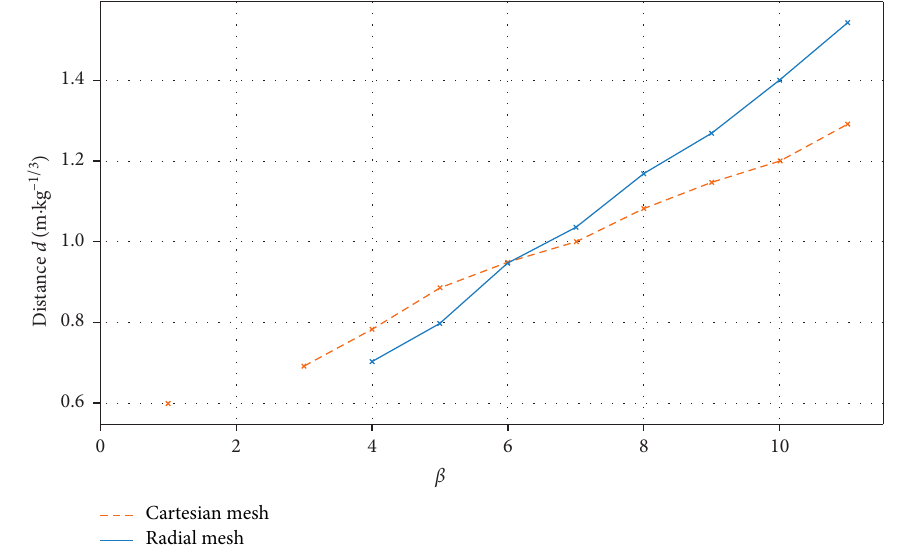
Figure 5: Scale distance d